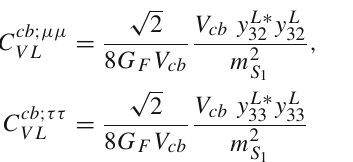
orangelineillustratethecurrentandfuturereachofconstraintfromneu- tron EDM for purely imaginary φ ττ , as it probes CP violation. The light gray shaded regions in both panels are excluded by ATLAS pp → ττ search [48]. See text for further